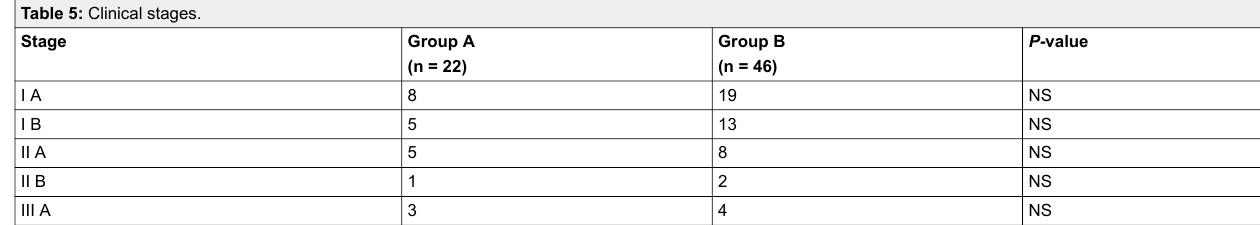
Table 5: Clinical stages.